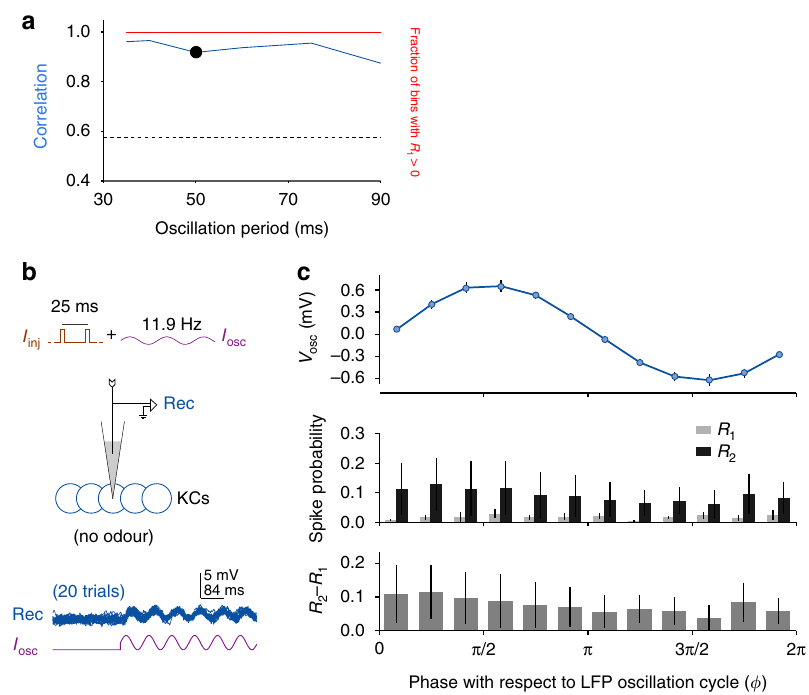
Figure 5 | KCs form integration windows robustly even at frequencies other than 20Hz. ( a ) The computational model predicted phase-dependent summation for a wide range of oscillation cycle periods (this panel uses the same format as Fig. 3d). ( b ) In vivo test: experiment design is similar to the one shown in Fig. 4: Oscillatory input with an arbitrary frequency of 11.9Hz (84-ms period) was injected into the KC along with pairs of current pulses. Bottom: membrane potential oscillations generated by the current in a representative neuron (first 500ms of current injection is shown), from n ¼ 10 KCs. ( c ) Current injections at 11.9Hz generated robust oscillations in the subthreshold membrane potential of the KC. KCs exhibited integration windows: R 2 (cid:2) R 1 showed the same phase-dependence as seen previously with 20-Hz oscillations (Fig. 2). Error bars represent